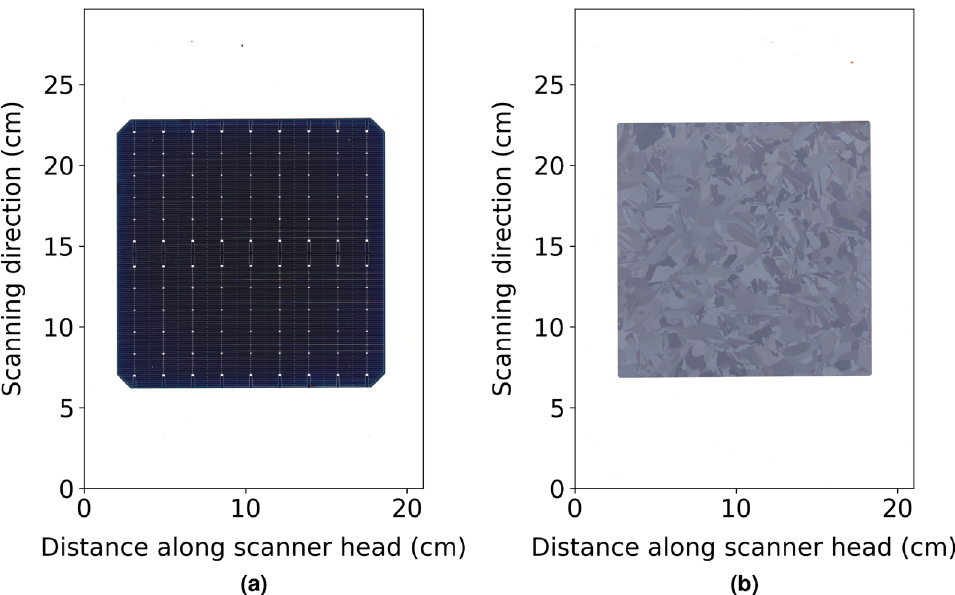
Figure 6. Example scan of ( a ) a silicon solar cell from a 2020 manufacturing line and ( b ) textured multi- crystalline wafer used in this study. The scan has 118 pixels per cm and was taken with a CIS based Canon Lide 300. The axes are labelled to represent the location of the scanner head and its